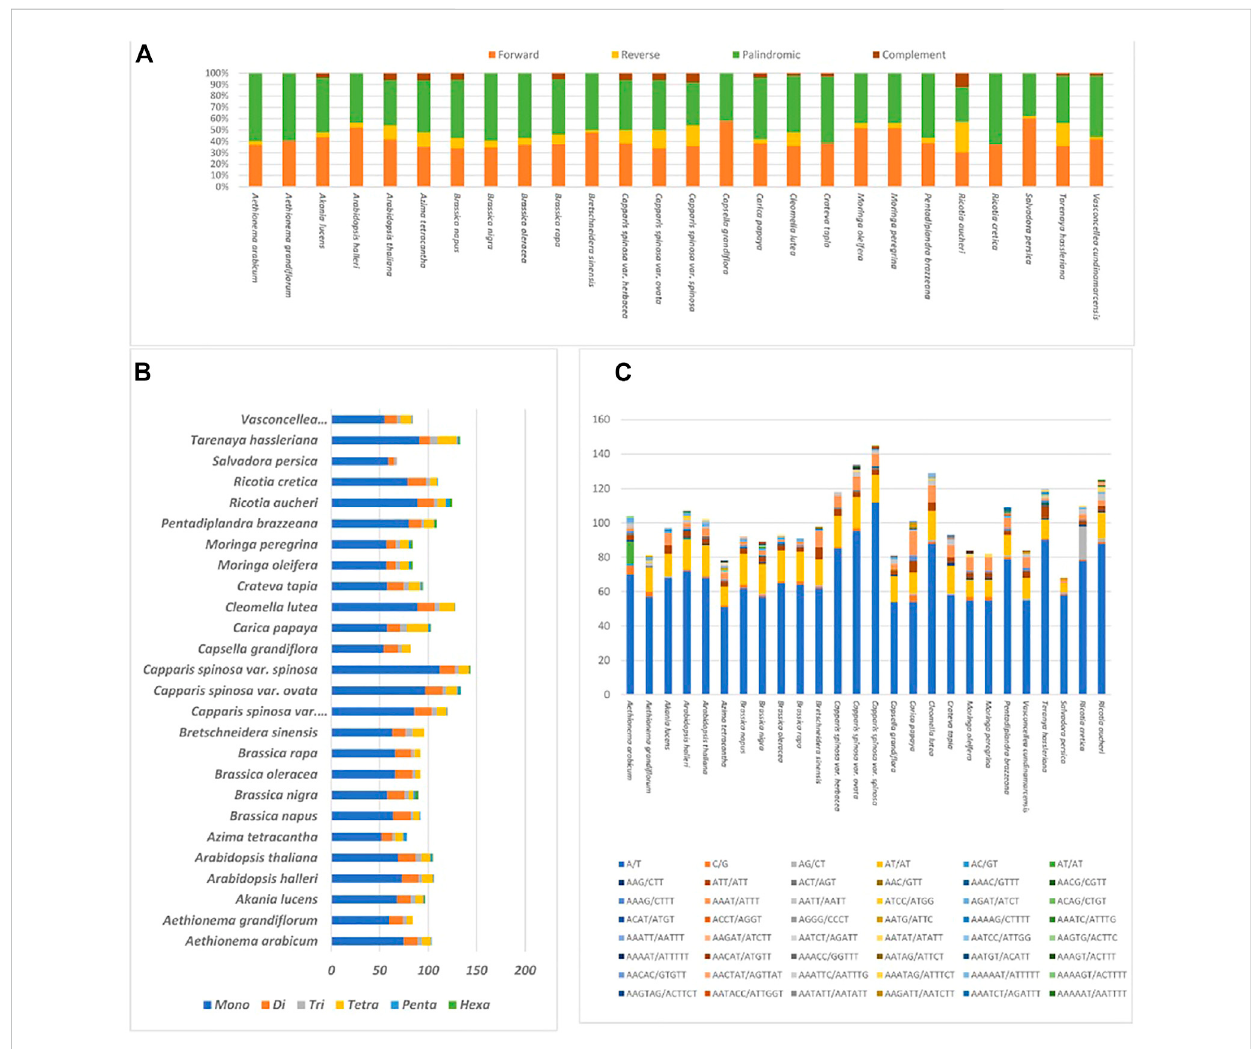
FIGURE 5 Plastomesamplesof26relativespecies (A) .Totalmotifsofrepeatsequencesidenti fi edindividually (B) .TotalmotifsofvariousSSrstypesestimatesin each specie (C) . Total types of SSRs motifs in each